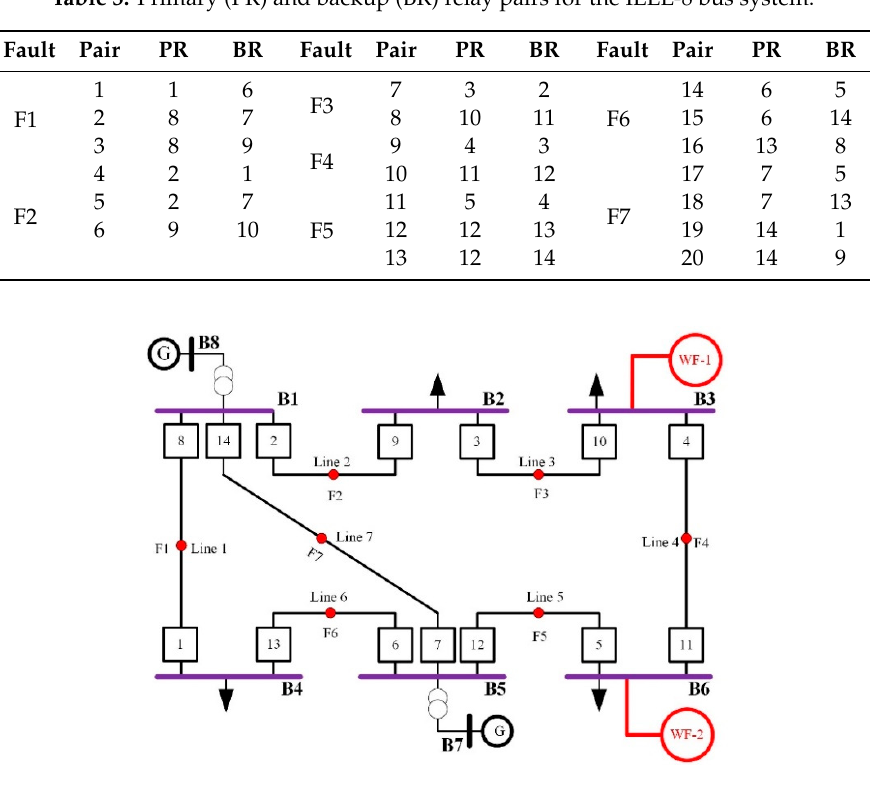
Figure 10. Standard IEEE-8 bus system modified by integrating wind turbine generators.